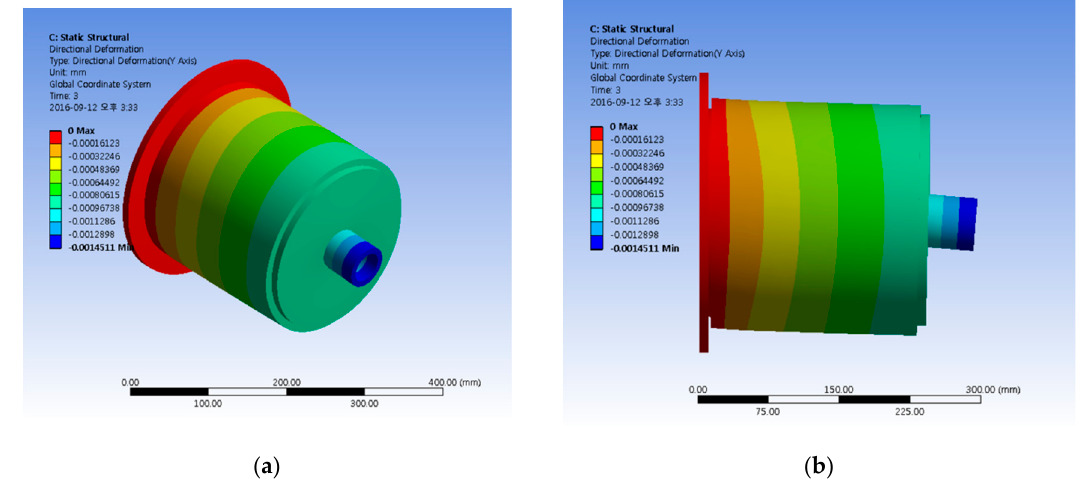
Figure 23. Deflection contours on the magnet coupler for the case where the bulkhead thickness is 4 mm and the blade and hub weight of 1100 N. ( a ) The isometric view of the model. ( b ) The side elevation of the magnetic coupler shows the largest displacement occurring at the end of the hub connection.